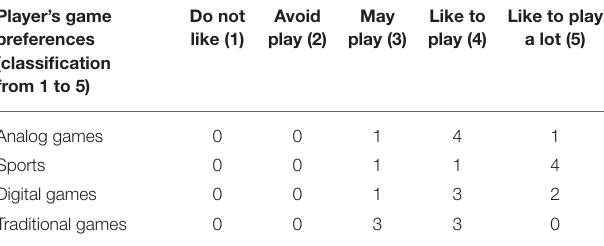
TABLE 2 | Gaming preferences from